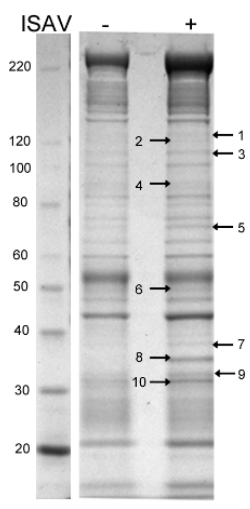
Figure 8. Commassie stained protein gel of ASK cell lysates and proteins pulled down by immunoprecipitation with anti-s8ORF2 from non-infected ( − ) and ISAV infected (+) cells four days post infection. Arrows and numbers indicate protein bands excised for LC/MS analysis.